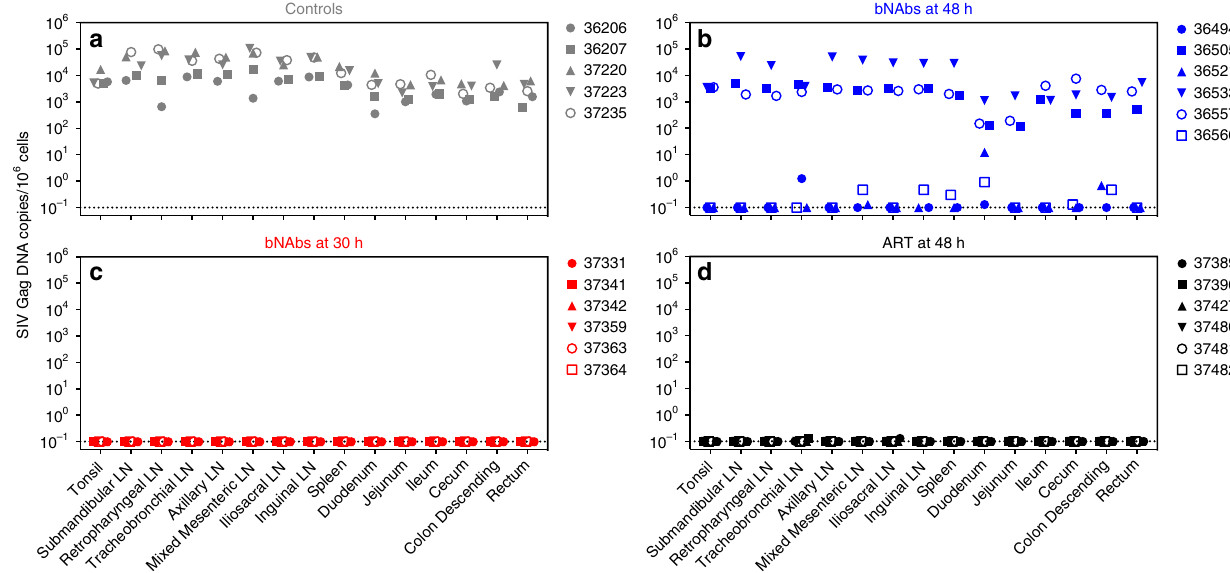
Fig. 4 bNAb and ART treatments reduce virus in tissues. Tissues were harvested at time of death and total viral DNA was quanti fi ed using an ultrasensitive SIV DNA qPCR assay. Total viral DNA quantities are shown for the tissue types listed along the bottom of the fi gure. a Group 1 (untreated controls). b Group 2B (bNAbs at 48 h). c Group 3 (bNAbs at 30 h). d Group 4 (ART at 48 h). All data shown is from tissues harvested at time of death. Group colors and individual animal symbols are consistent throughout the manuscript. See Supplementary Tables 2 – 6 for numerical data from these and other treatment regimen were signi fi cant determinants. However, the single-dose treatment at 30 h (Group 3) resulted in a signi fi cantly longer half-life than the 4-dose treatment at 48 h (Group 2B) regardless of the bNAb ( p < 0.0001) (Supplementary Fig. 4b).